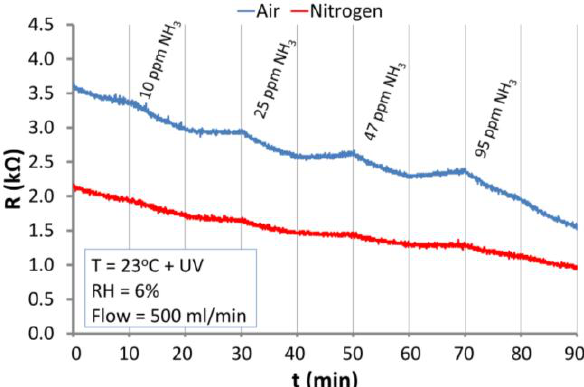
Figure 13. The response of the ZnO nanostructures to NH 3 under continuous UV irradiation under atmospheres of air and nitrogen at RT (23 °C).